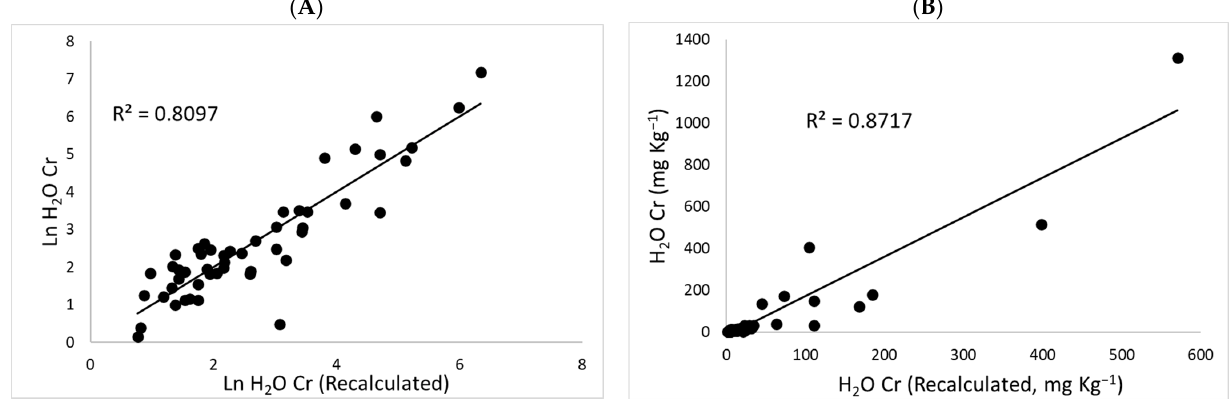
Figure 1. Goodness of fit for measured and recalculated fractions of H 2 O Cr in ( A ) logarithmic scale and in ( B ) mg of Cr Kg –1 of soil.